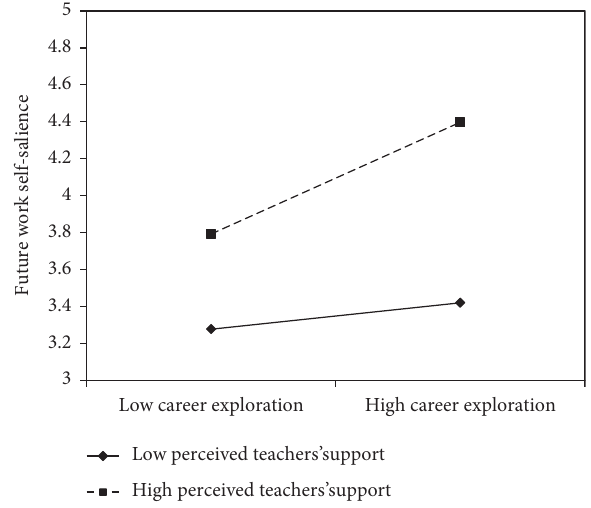
Figure 3: The effect of the interaction between career exploration and perceived teacher support on future work